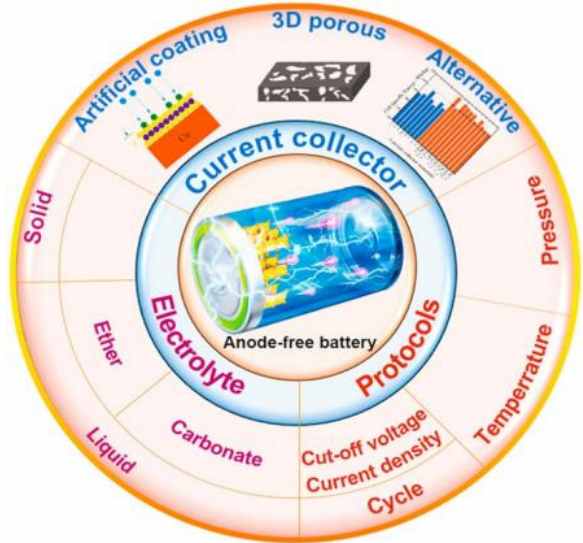
Figure 1. Schematic diagram of anode-free batteries. “Reprinted from The Lancet, Vol. number, Author(s), Title of article, Pages No., Copyright (2006), with permission from Elsevier”.